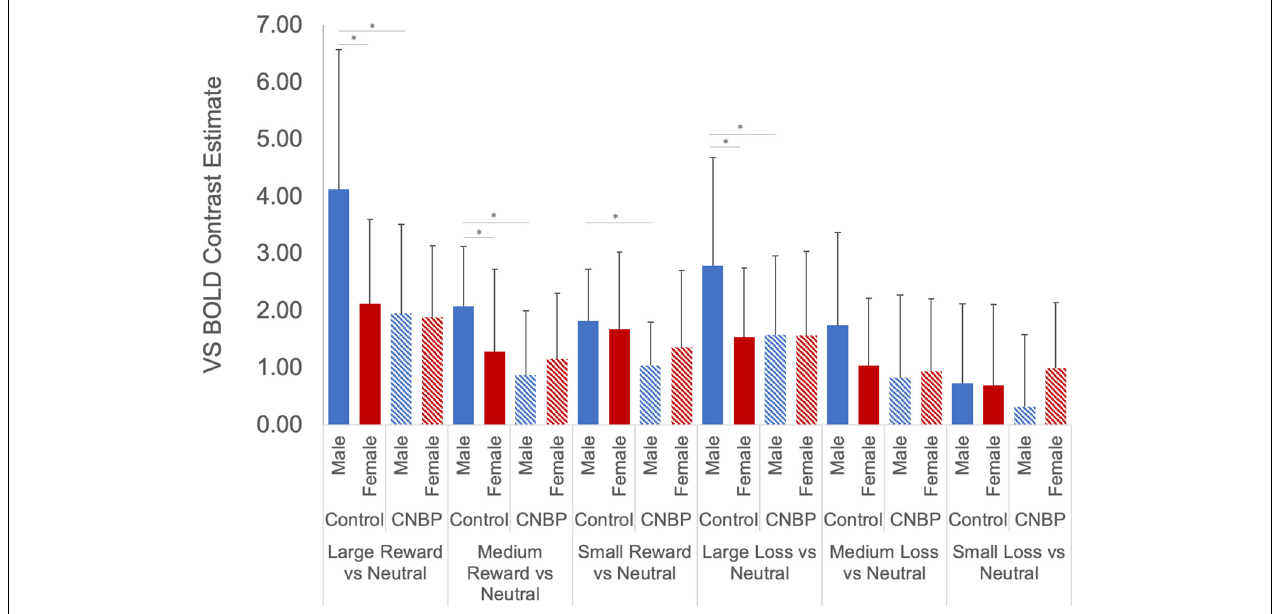
FIGURE 1 | Group by sex interactions during reward and loss anticipation. During large reward trials (relative to neutral), control males exhibited significantly greater reward-related activation than control females; this difference was not observed between patient males and females. Significant differences were observed between control males and females for large rewards ( p = 0.002) and medium rewards ( p = 0.04). No such differences were observed between patient males and females ( p = 0.89, p = 0.42, respectively). Significant differences were also observed between control males and patient males for large rewards ( p = 0.002), medium rewards ( p = 0.001), and small rewards ( p = 0.005). No such differences were noted between control females and patient females ( p > 0.40). During large loss trials (relative to neutral), control males exhibited significantly greater loss-related activation than control females ( p = 0.02); this difference was not observed between patient males and females. Significant differences were also observed between control males and patient males for large rewards ( p = 0.04). No such differences were noted between control females and patient females. Error bars represent confidence intervals. VS, ventral striatum. * denotes significant differences.